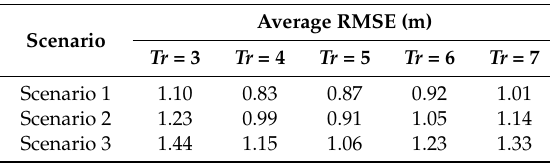
Figure 21. ( a ) Average RMSE of the still target estimated by different numbers of anchor nodes in testing scenario 2; ( b ) Average RMSE of the still target estimated by different learning speed coefficients in testing scenario 2. Table 1. Average RMSE of the still target estimated by different numbers of anchor nodes in the three testing scenarios.